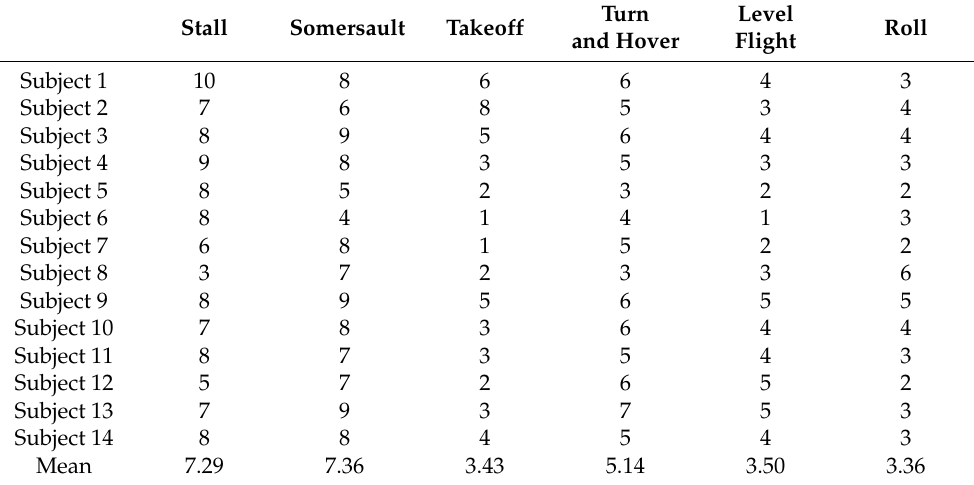
Table 7. Difficulty level rating according to subjective